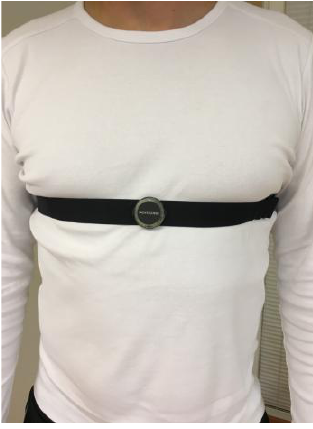
Figure 3. The position of the sensor was changed to the chest of the subject.